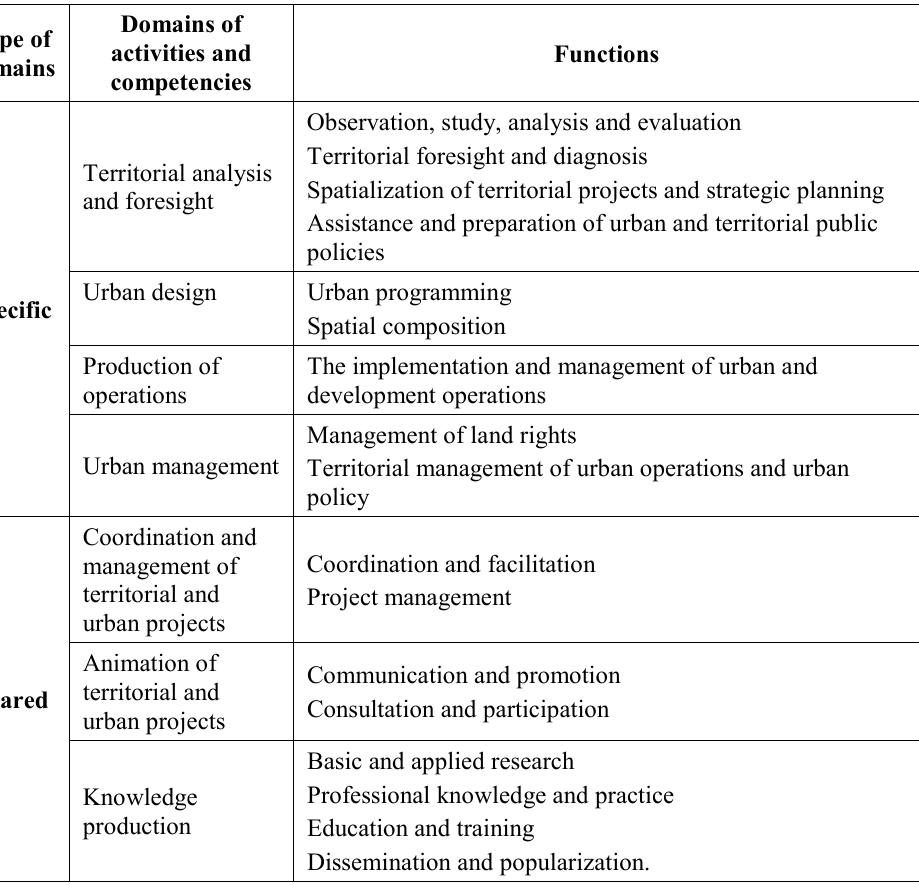
Table 1. Activities and Competency Framework of Urban Planner Trade of the